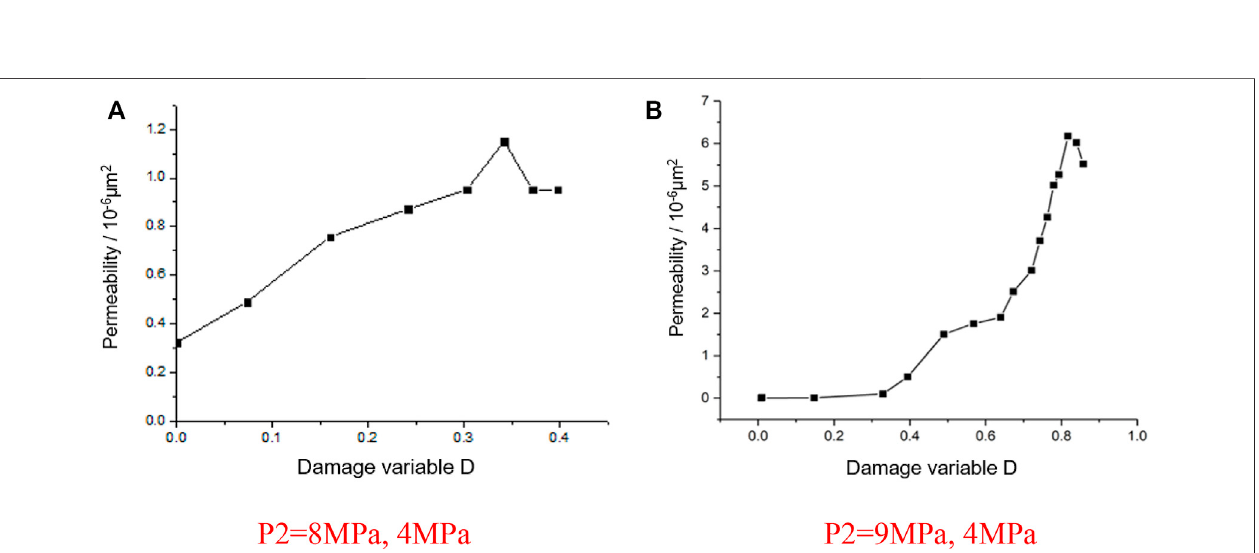
Frontiers in Earth Science |